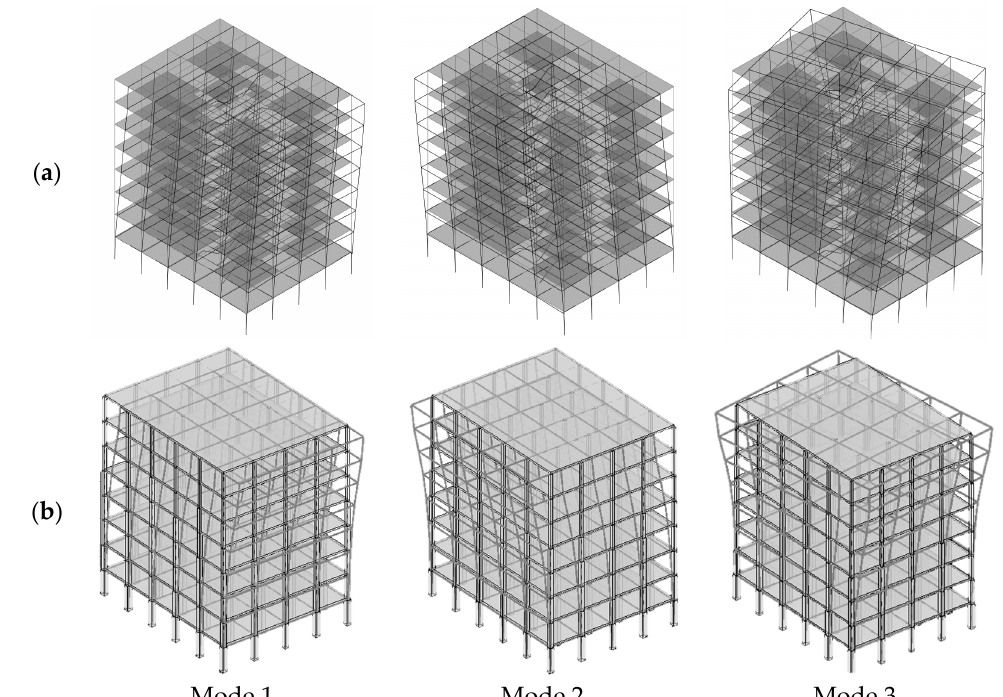
Table 3. Modal Period comparison.